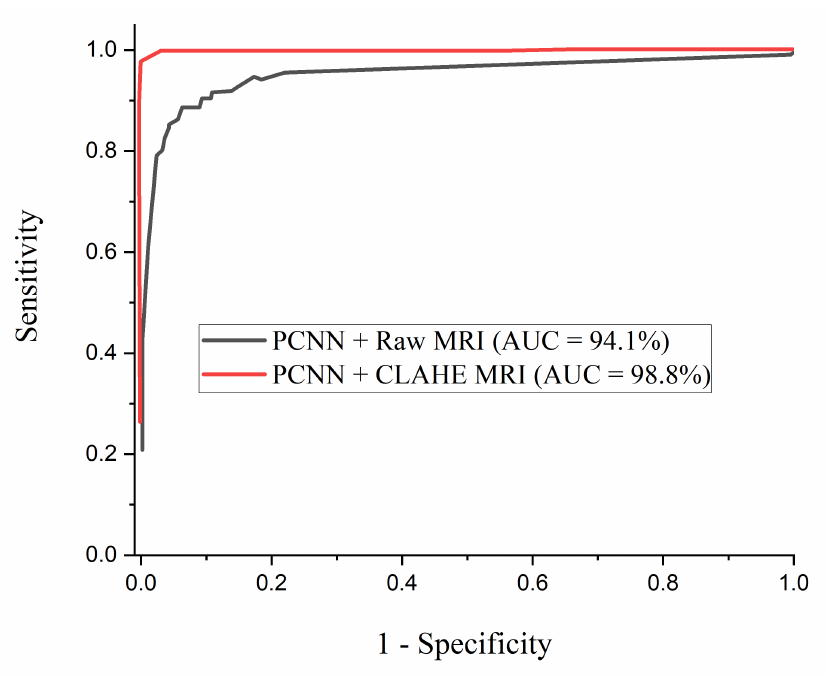
Figure 7. ROC curves for the proposed PCNN in comparison with raw MRI and CLAHE pre- processed MRI